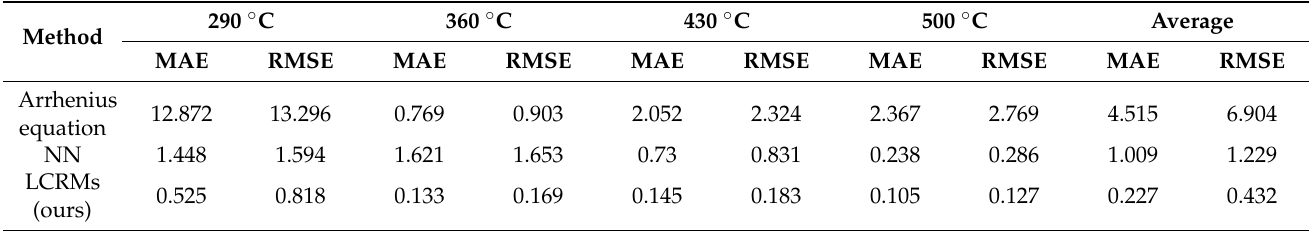
Table 3. MAE and RMSE for three